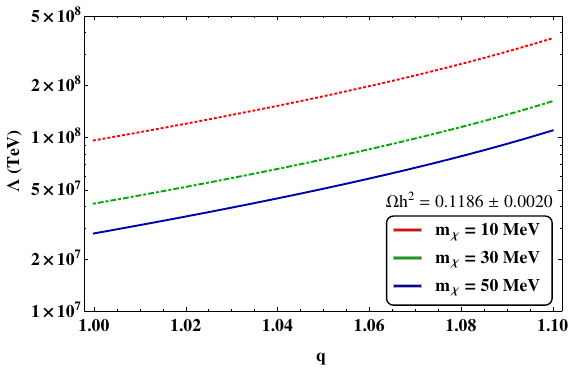
Figure 3 . (cid:3) (in TeV) is plotted against m (cid:31) (in MeV) for q = 1 and q = 1 : 1.